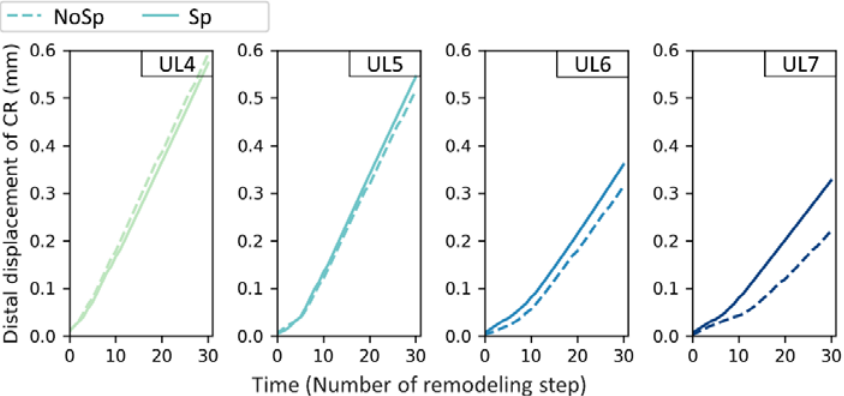
Figure 4. Changes in the distal displacement of the center of resistance (CR) of each tooth over time. More distalization was observed in the Sp model. Line colors indicate tooth type.